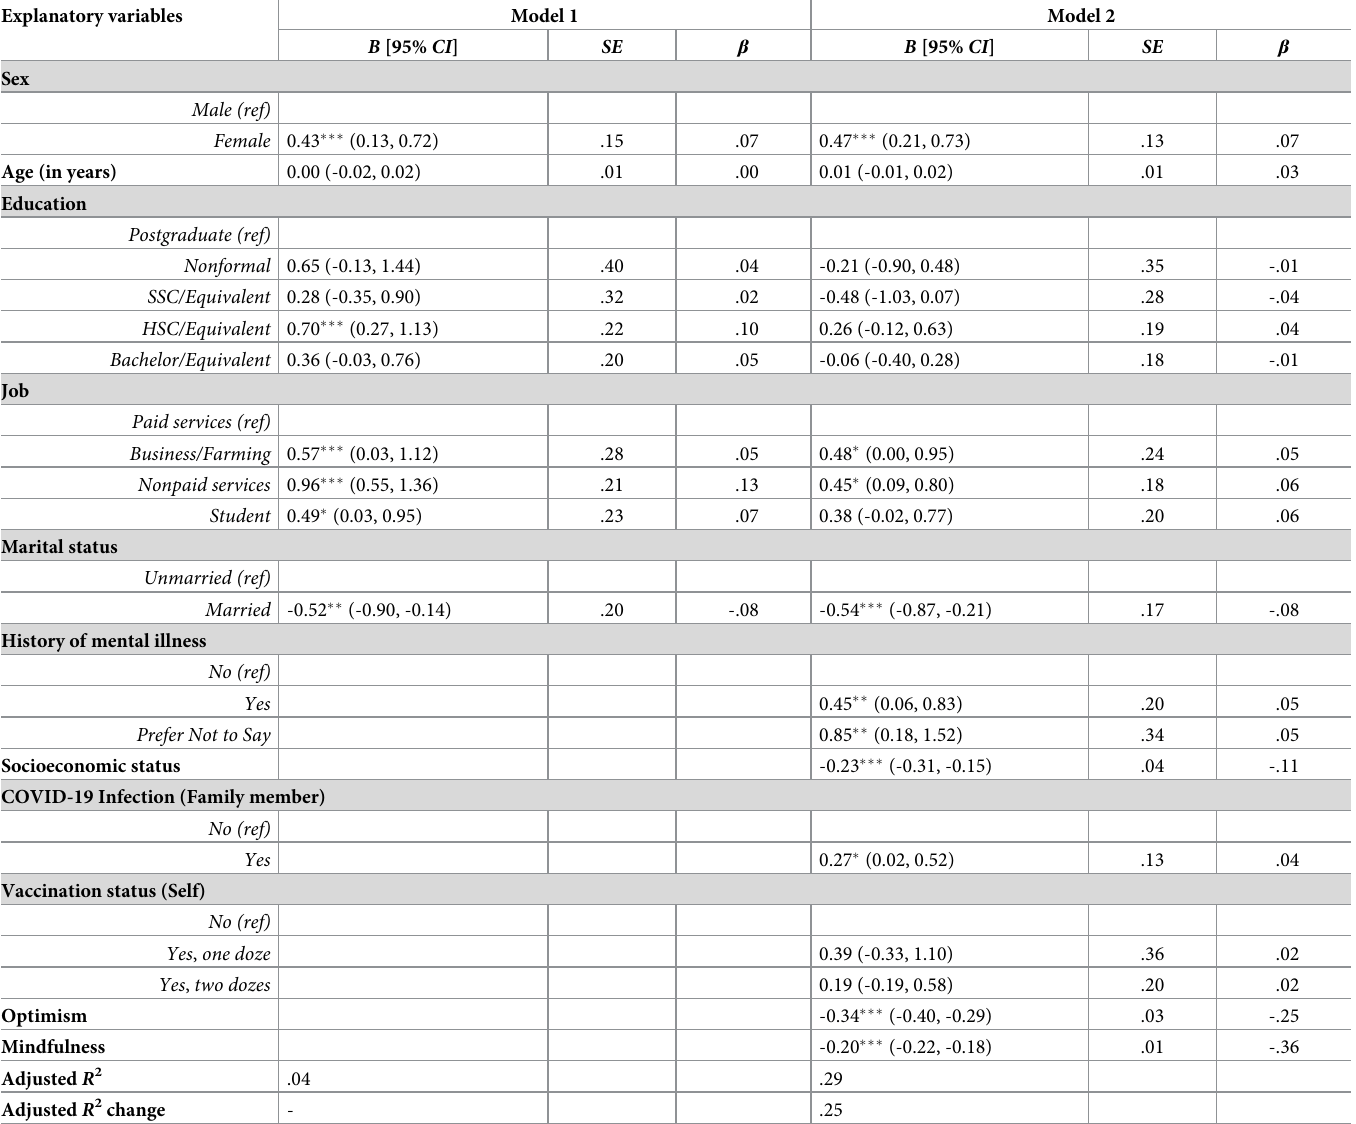
Table 5. Nonmodifiable and modifiable factors associated with perceived stress among Bangladeshi adults ( N = 1897). Explanatory variables Model 1 Model